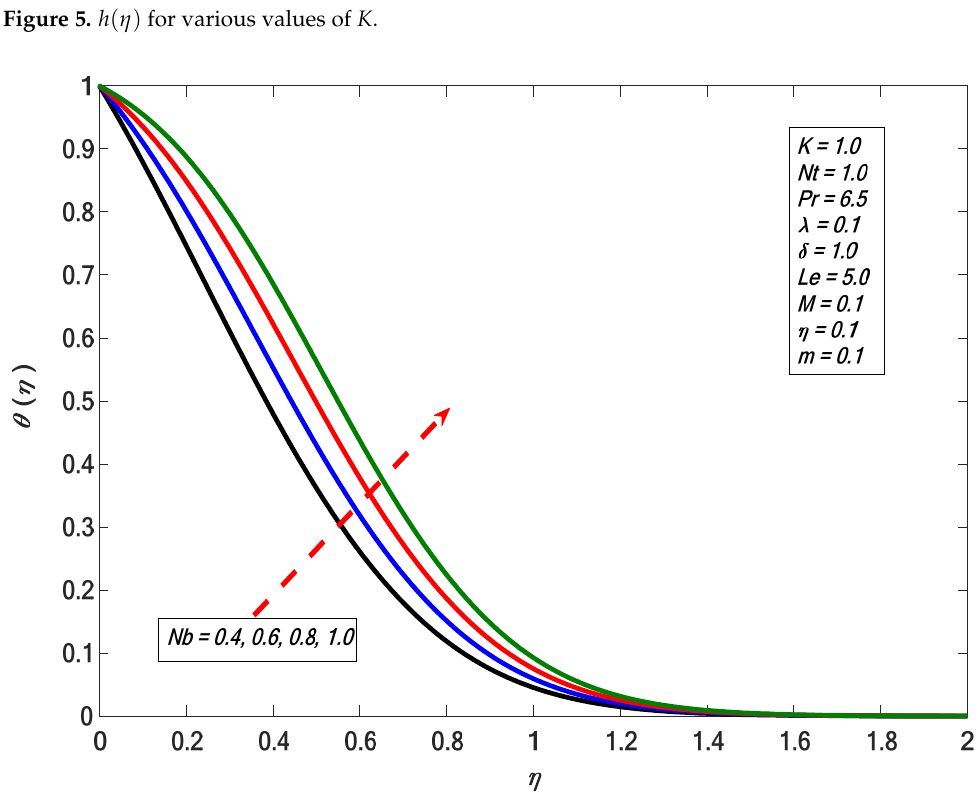
Figure 6. θ ( η ) for various values of Nb Figure 6. 𝜃(cid:4666)𝜂(cid:4667) for various values of 𝑁𝑏.